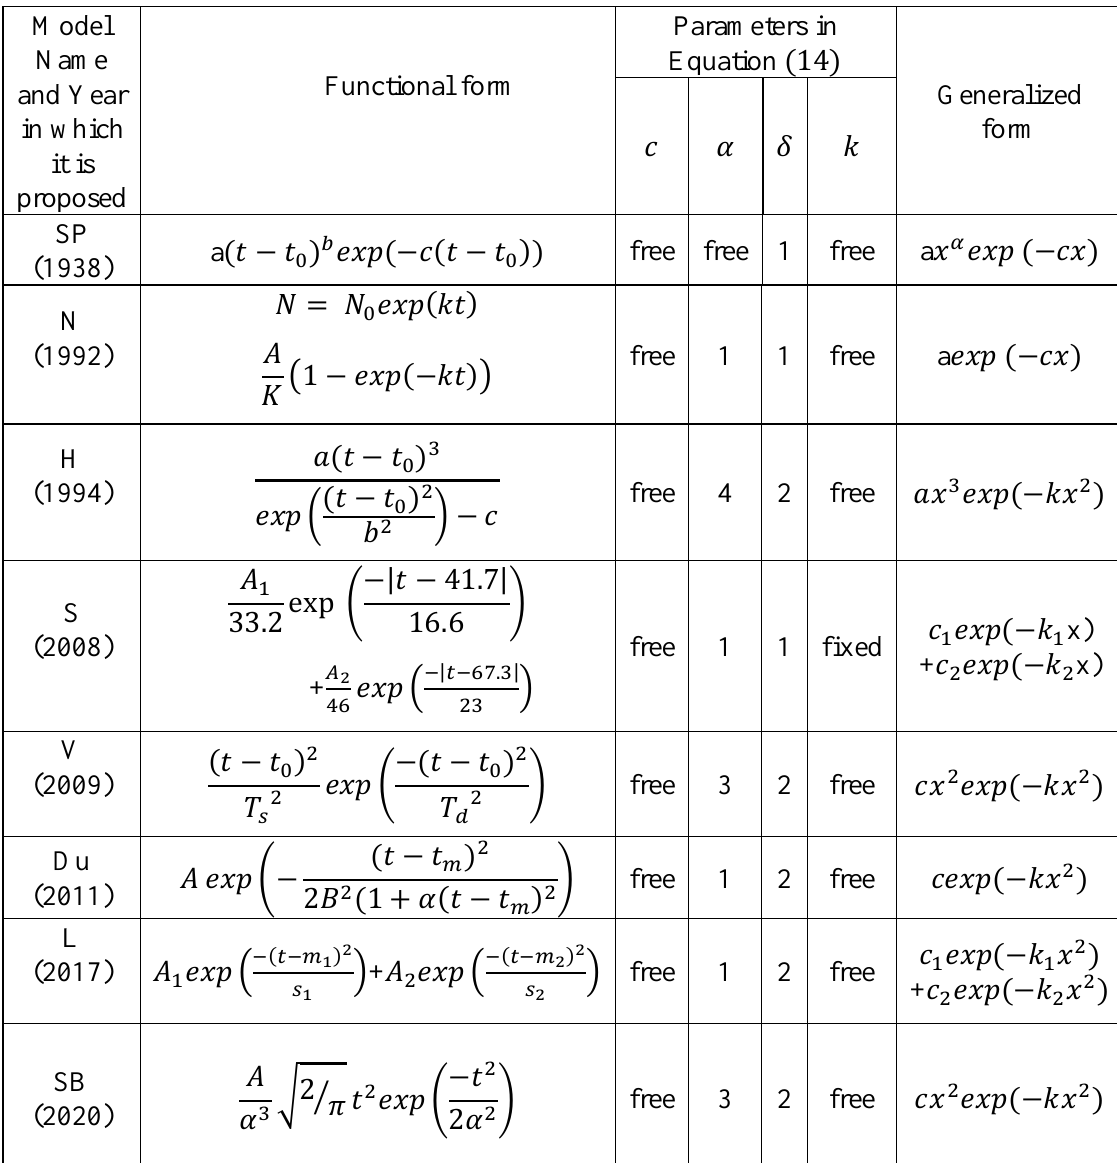
Table 1. Different models, their parameters and its